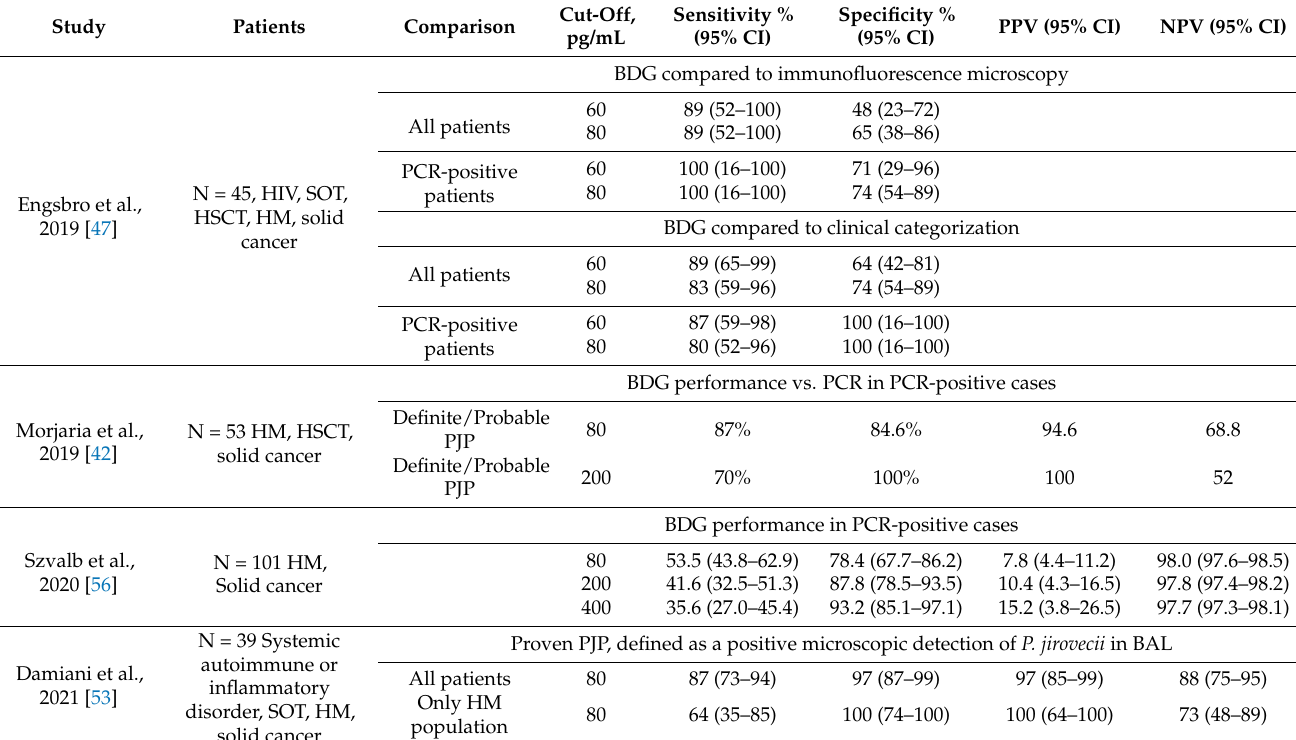
Table 3. The performance of BDG assays in recent studies on pneumocystosis in patients with haematological malignancies